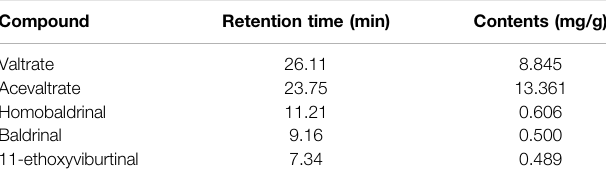
TABLE 4 | Contents of fi ve components in ZZX